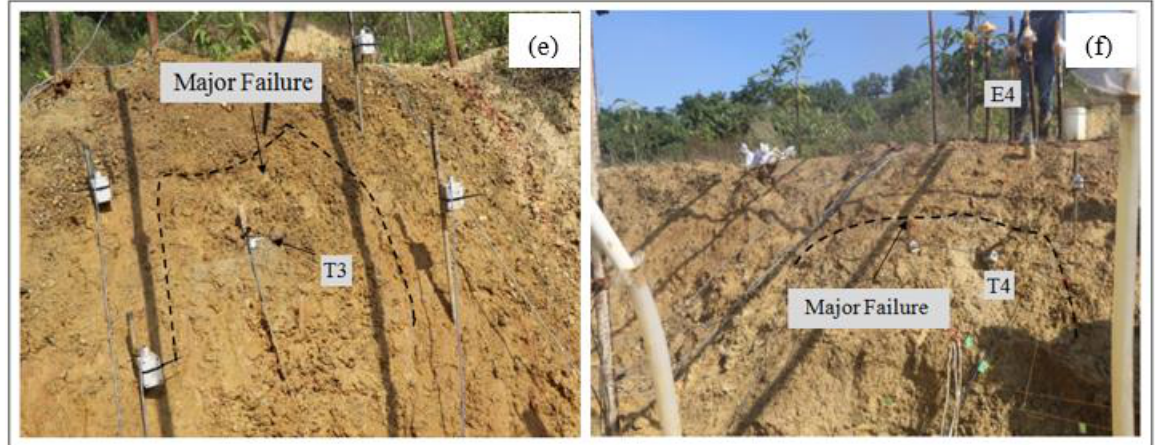
Figure 5. ( a ) The arrangement of instruments in Field Test 1; ( b ) The arrangement of instruments in Field Test 2; ( c ) The test slope in field test 1; ( d ) The test slope in Field Test 2; ( e ) The major failed part of the test slope in Field Test 1; ( f ) The major failed part of the test slope in Field Test 2. Tilt sensors and extensometers which are noted by “T” and “E” were exploited in this test.